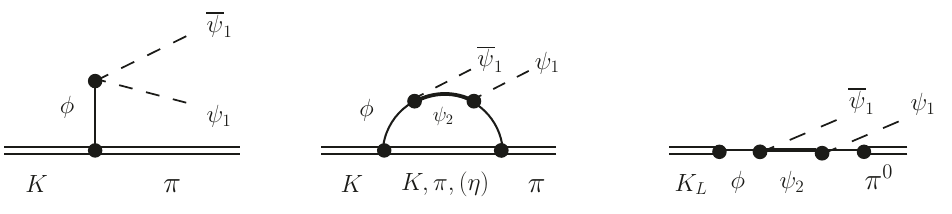
Figure 18 . The K (cid:25) 1 (cid:22) 1 in the fermion Model 3 with contribution evaluated in eqs. (4.3) ! and (5.8) respectively. The third diagram only contributes to K L suggests, and is therefore responsible for potential violation of the GN bound in Model